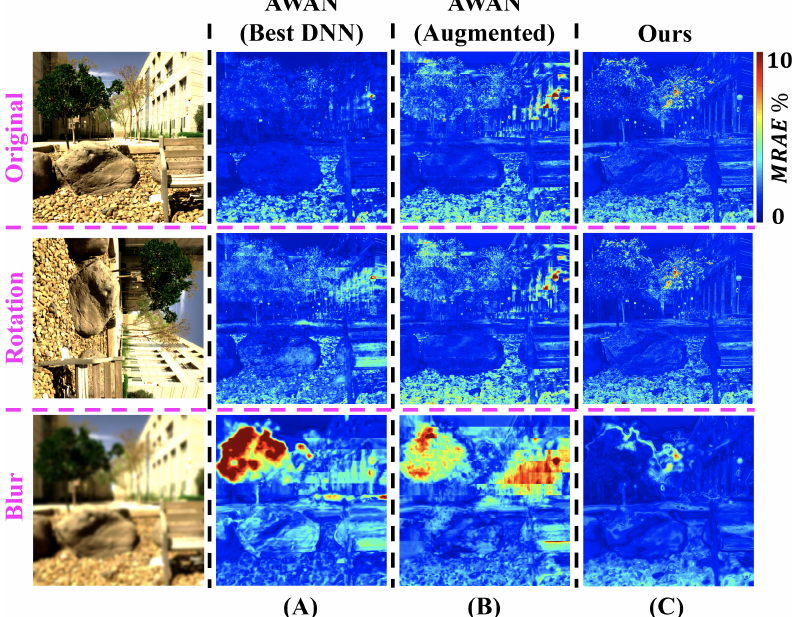
Figure 2. The SR mean-relative-absolute error (MRAE) maps of ( A ) the leading deep neural network (DNN) “AWAN” [35], ( B ) our data-augmented AWAN and ( C ) our pixel-based “A++”, under the original, rotation and blur conditions. The error maps of the “rotation” experiments are rotated back to upright orientation to ease